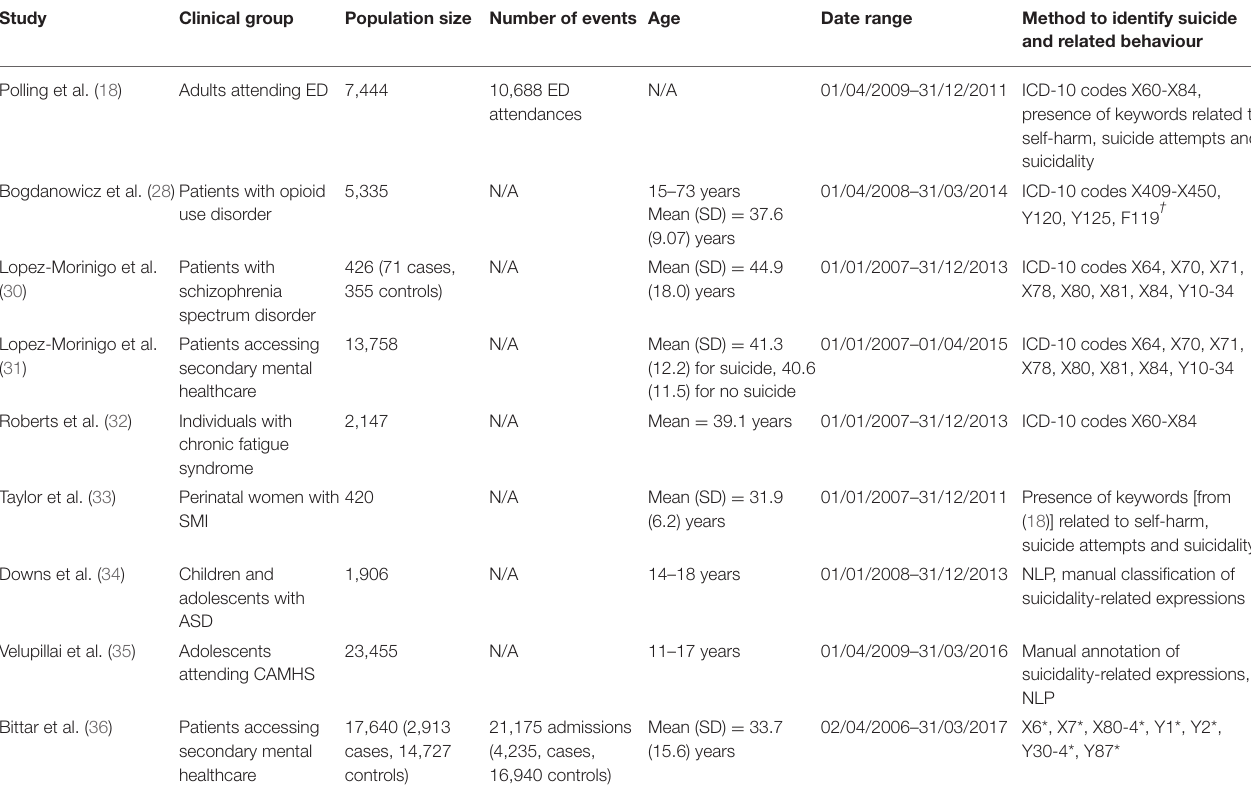
TABLE 1 | Summarised characteristics of clinical cohorts created using CRIS for the study of suicide and related behaviour. Study Clinical